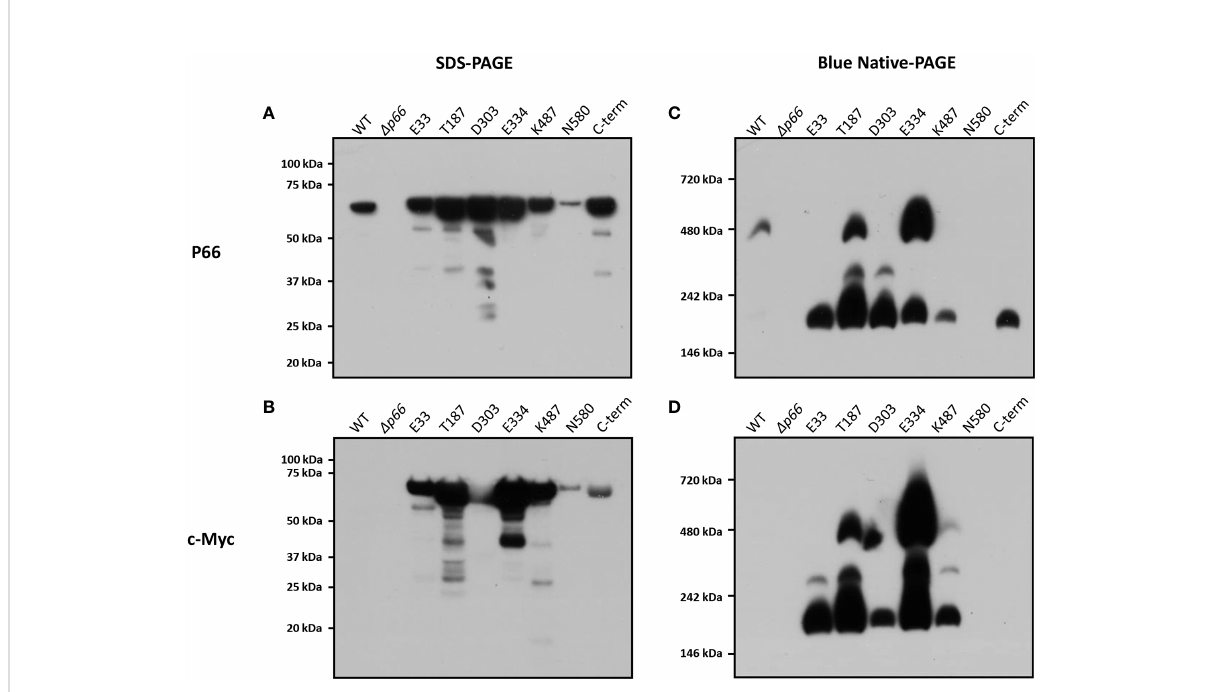
FIGURE 5 BN-PAGE, SDS-PAGE, and western blot analyses of P66 and the c-Myc tag reveal oligomerization state of B31 A3 c-Myc P66 cp strains. The outer membrane fractions of B . burgdorferi strains were subjected to SDS-PAGE (A, B) or to BN-PAGE (C, D) . Immunoblot analyses were performed using anti-P66 (A, C) or anti-c-Myc antibodies (B, D)